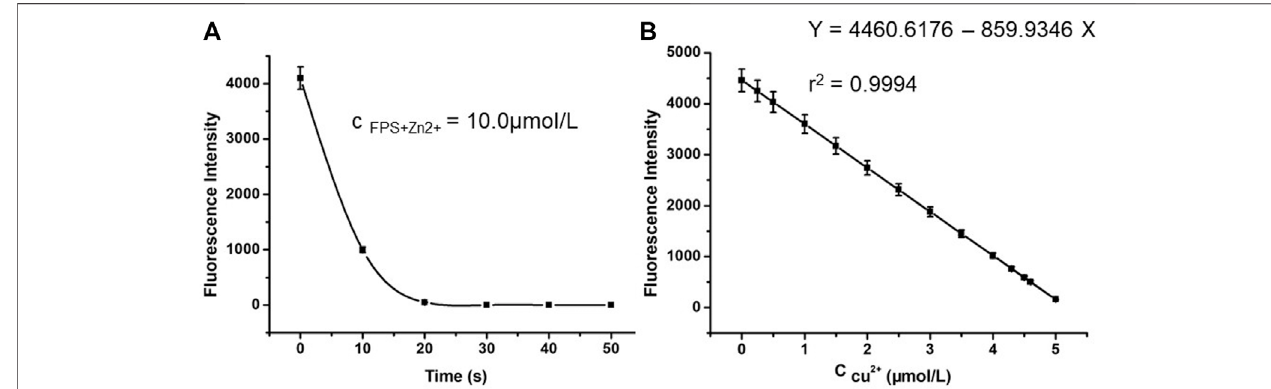
Frontiers in Chemistry |